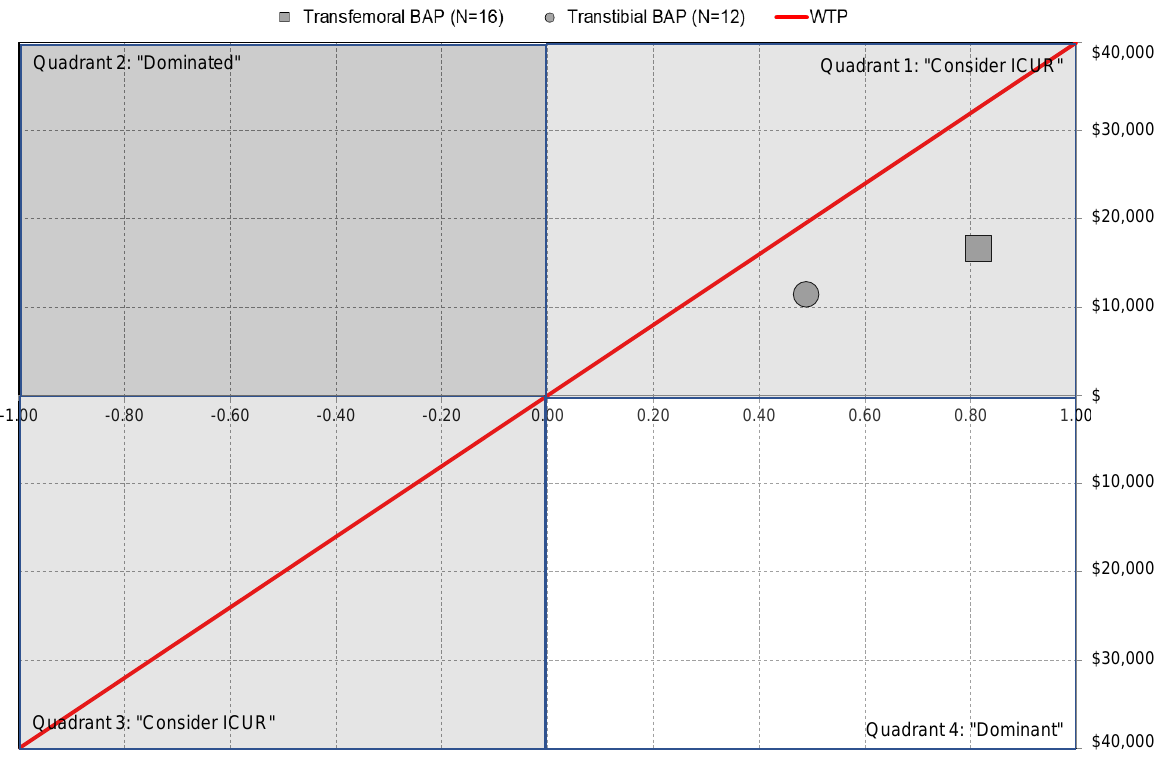
Figure 6: Overview of cost-utility analysis showing indicative incremental cost-utility ratio of AUD$16,632 and AUD$11,453 per quality- adjusted life-year (QALY) and willingness-to-pay threshold (WTP) of AUD$40,000 per QALY for transfemoral (2016-2017 prices: 1 Australian dollar ≈ 0.71 Euro ≈ 0.60 British pound ≈ 0.76 US dollar) and transtibial (2018-2019 prices: 1 Australian dollar ≈ 0.63 Euro ≈ 0.54 British pound ≈ 0.71 US dollar) bone-anchored prosthesis (BAP) that were more costly and more effective than socket-suspended prosthesis (Quadrant 1) and below WTP from Queensland Artificial Limb Service’s (QALS) prosthetic care perspective, respectively (N: Number of consumers).